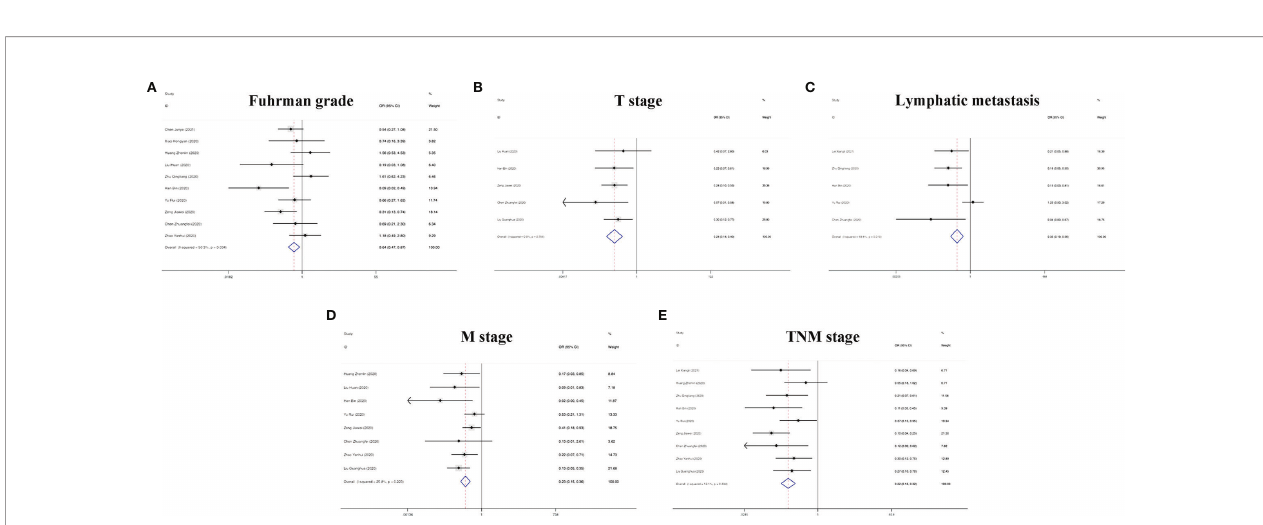
FIGURE 8 | (A) Bivariate boxplot, (B) Deeks ’ funnel plot, (C) Scatter plot, and (D) Fagan ’ s nomogram to illustrate the effect of circRNAs on the diagnosis of RC.